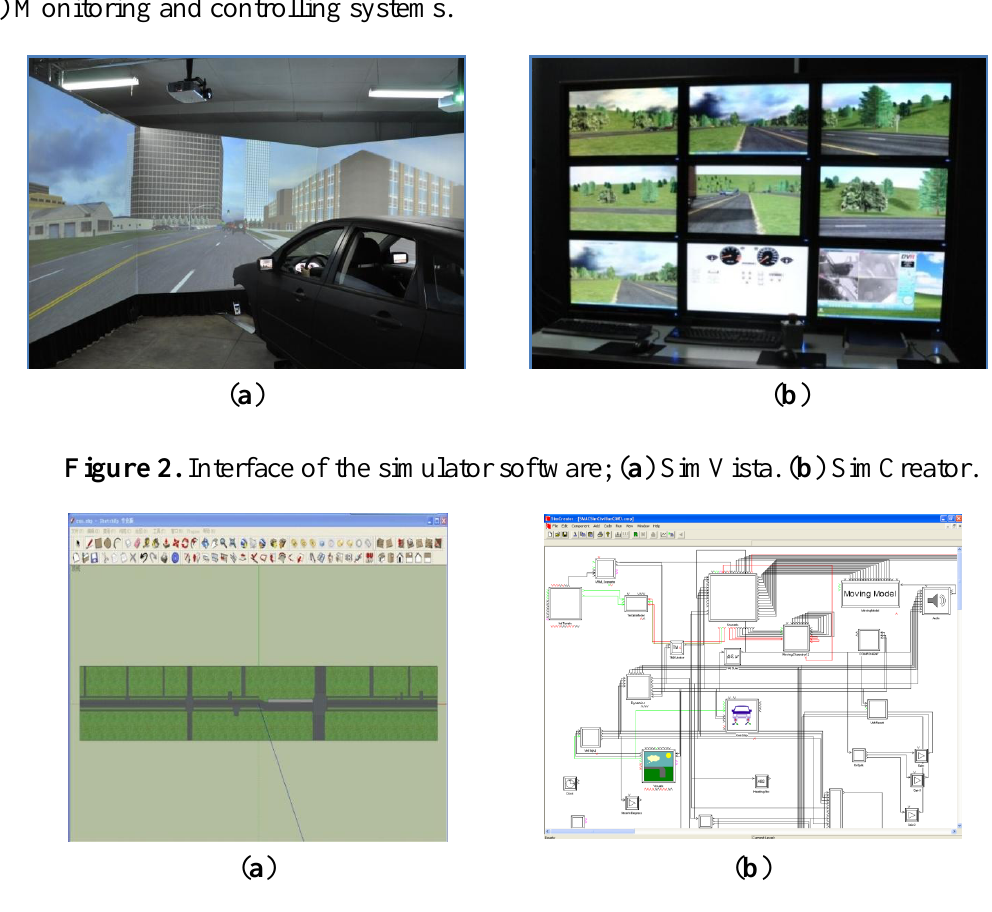
1. Illustration of the driving simulator system; ( a ) Driving simulator. ( b ) Monitoring and controlling systems.